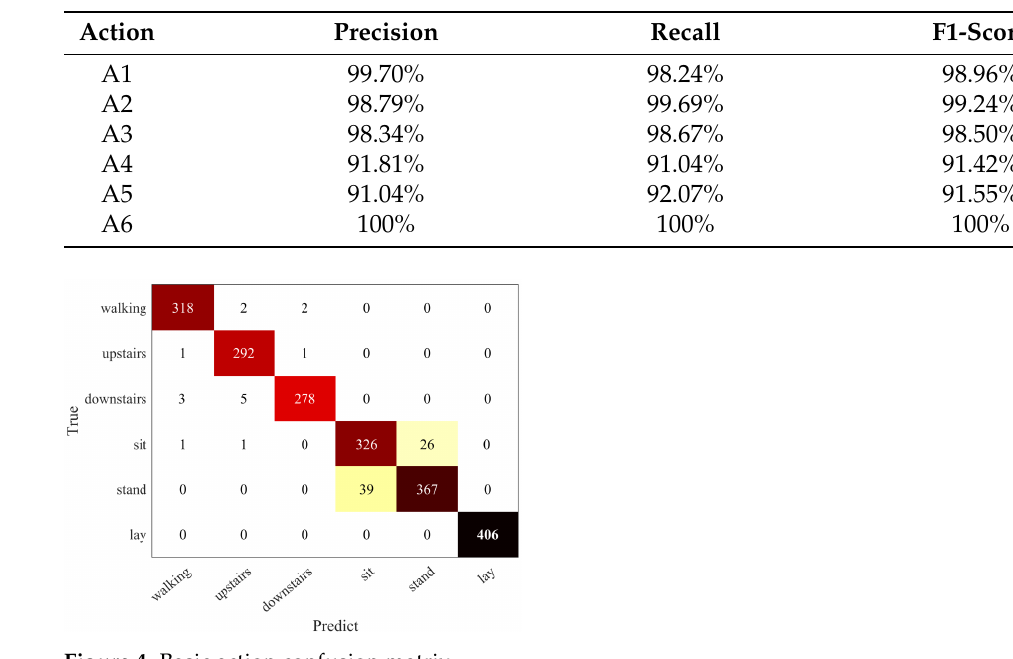
Table 4. Performance evaluation of each activity based on SVM classifier.